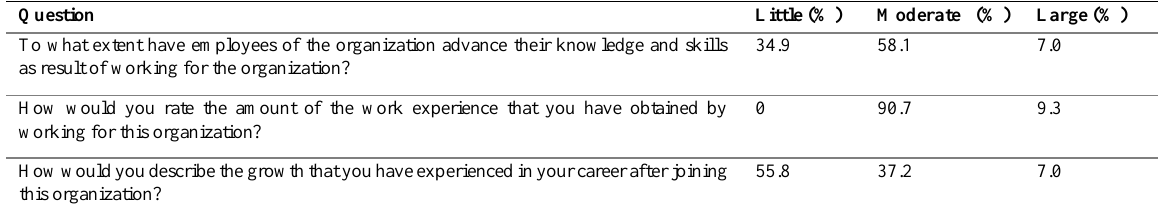
Table 3: Employees views of Growth of their Skills at TKNB